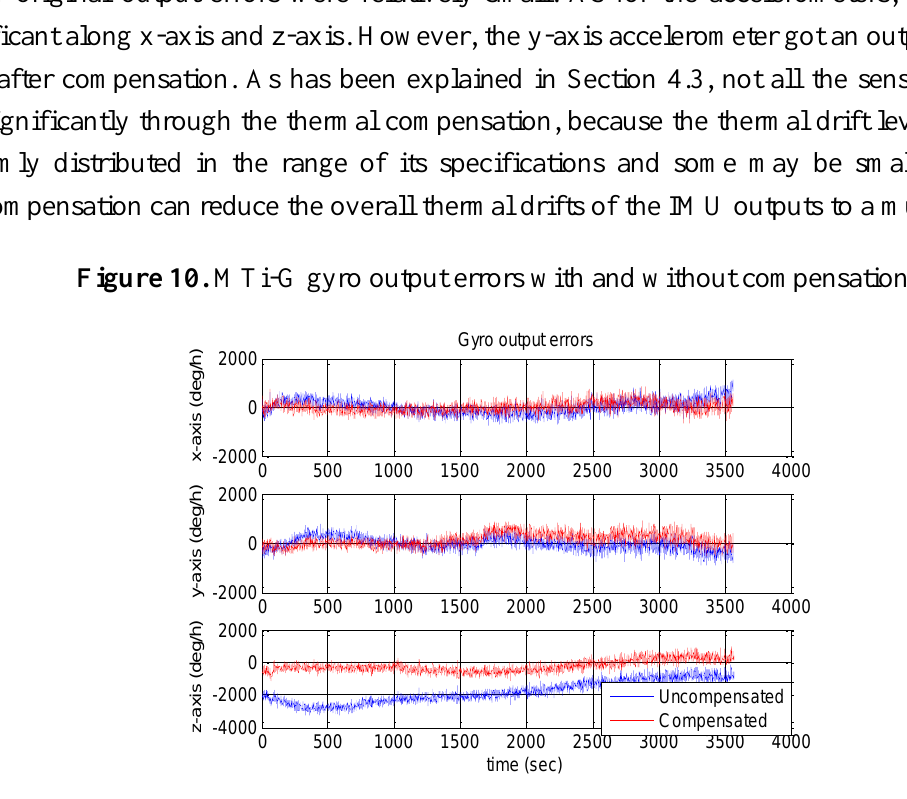
Figure 11. MTi-G accelerometer output errors with and without